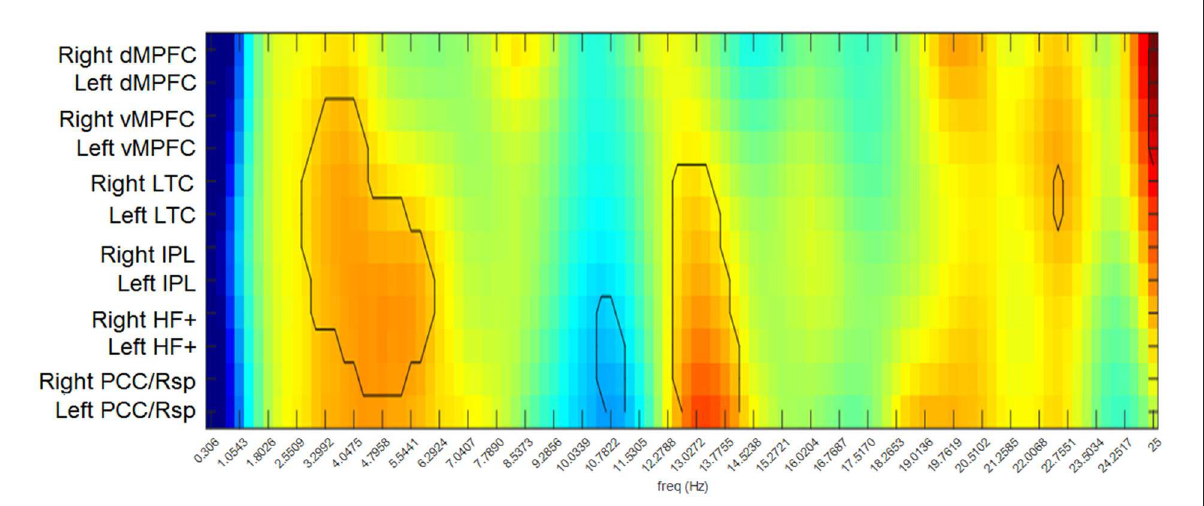
FIGURE3 Differences between groups in functional connectivity strengths for each node of the DMN. Warm colors indicate higher values in the RG than in the CG. Cool colors indicate higher values in the CG than in the RG. The contour indicates the comparisons that exceeded the probability threshold ( p = 0.05).